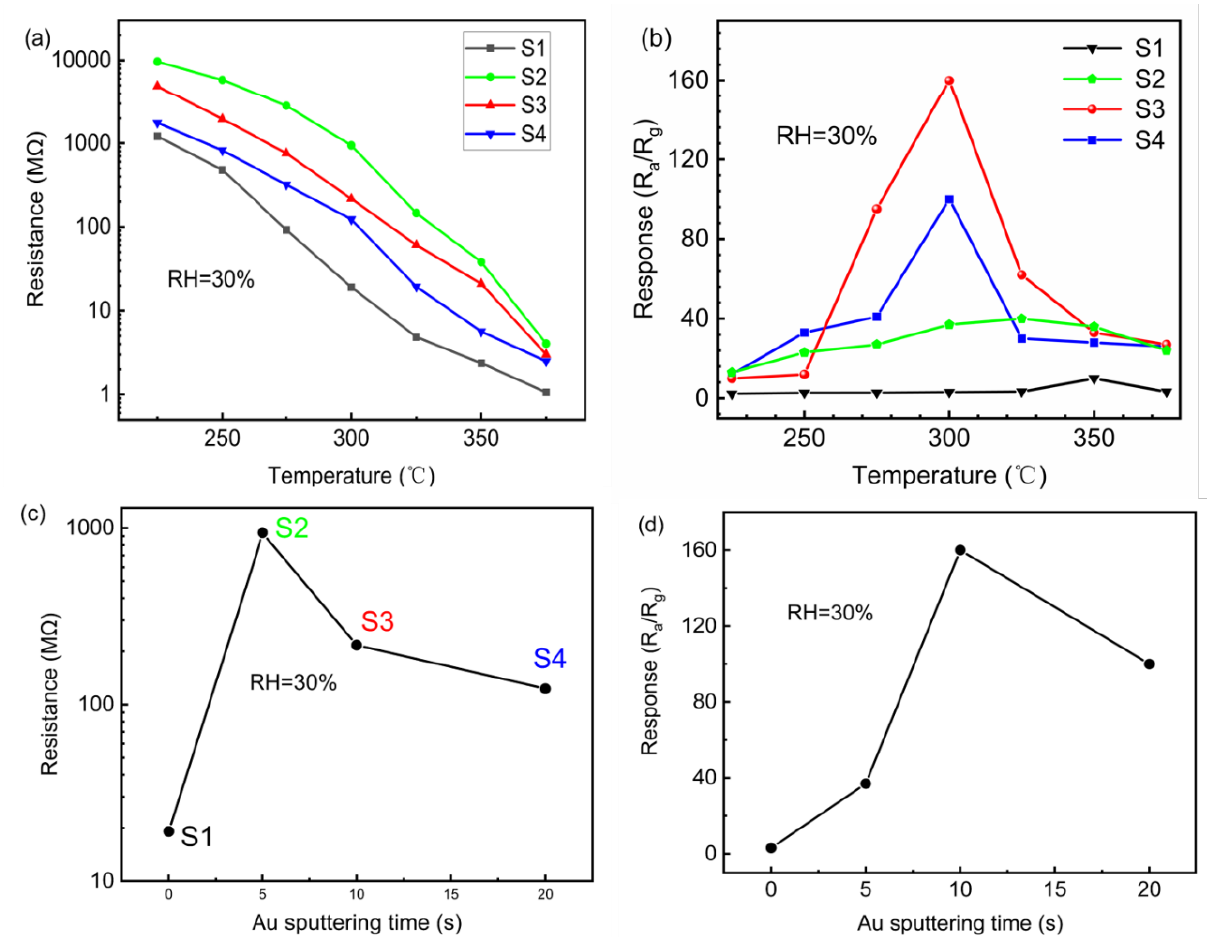
Figure 4. The initial resistance of as-obtained samples at various temperatures ( a ); the response of as-obtained samples toward 100 ppm IPA with operating temperatures ( b ); variation of initial resistance of all as-obtained samples at 300 ◦ C with Au sputtering time ( c ); variation of response of all as-obtained samples toward 100 ppm IPA at 300 ◦ C with Au sputtering time ( d ).